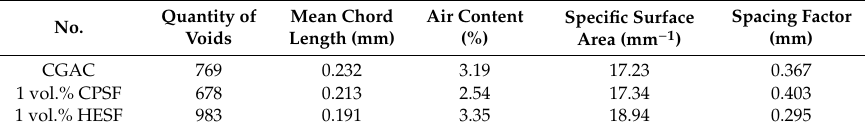
Table 7. Air-void characteristic parameters of CGAC with different steel fiber types.